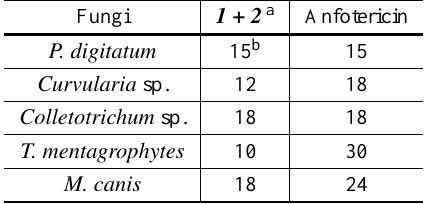
Antifungal activity of